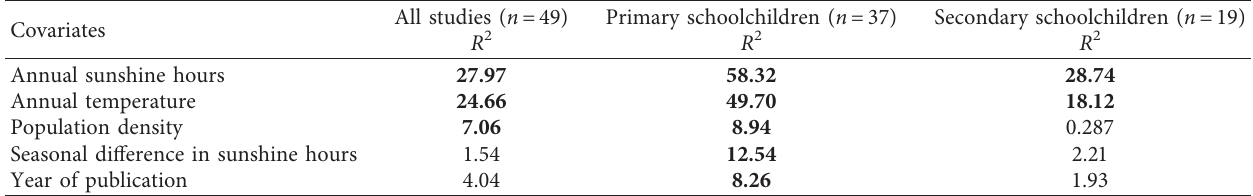
R 2 : coefficient of determination. The values highlighted in bold indicate a significant